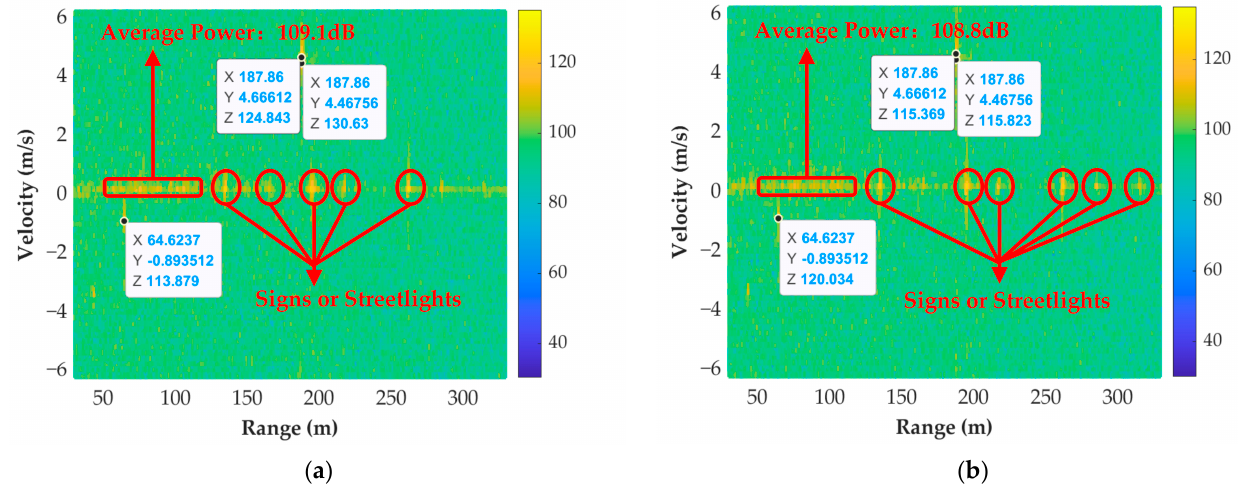
Figure 19. The optimal CoRS results in multiple-phase compensation groups. ( a ) Results of the vehicle. ( b ) Results of the pedestrian.